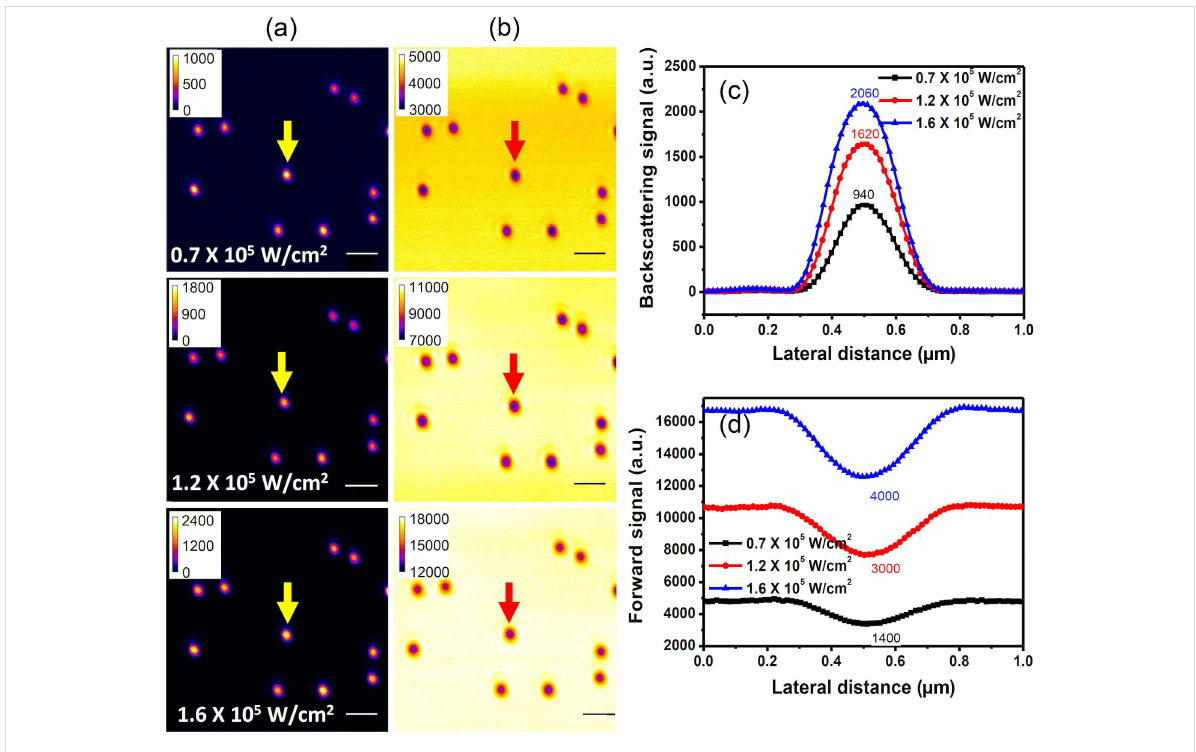
Figure 2: (a) Backward path and (b) forward path images of spherical gold nanostructures in the linear excitation regime. The x -scan signal profiles of the spherical gold nanostructure marked by an arrow in (a) and (b) are given in (c) and (d), showing the linear increase of the backscattering and the attenuation signals as functions of the excitation intensity. The number on each peak represents the signal height at the center of the PSF (positive for backscattering and negative for attenuation). The scale bar is 1